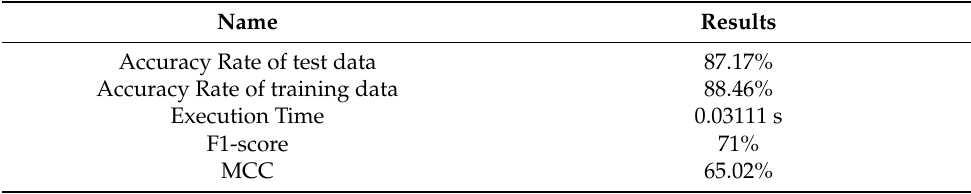
Table 6. KNN Classifier Results.